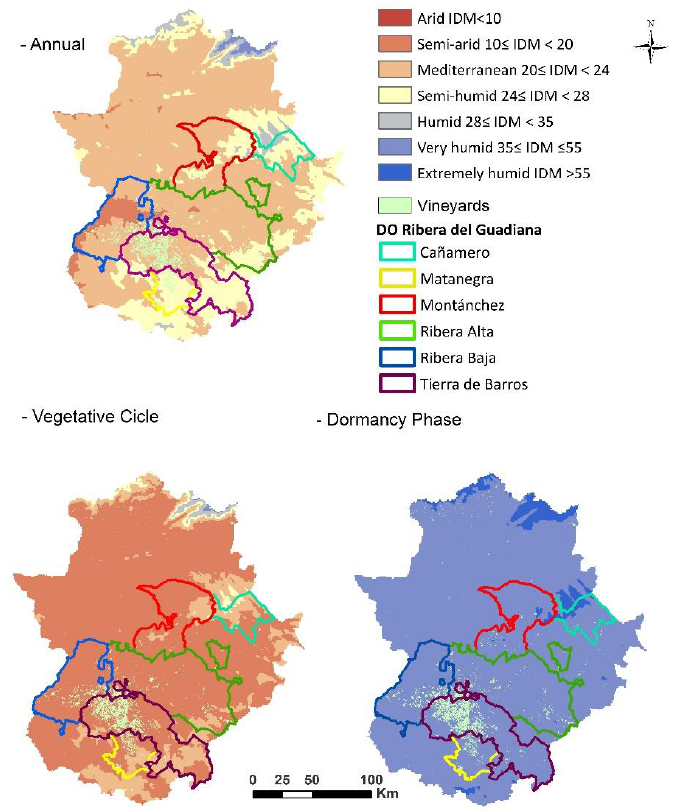
Figure 4. Spatial distribution of the De Martonne aridity index in Extremadura (1989–2020) for the anual, vegetative, and dormancy phases. Vineyards and subzones of the Ribera del Guadiana Protected Denomination of Origin are also shown.